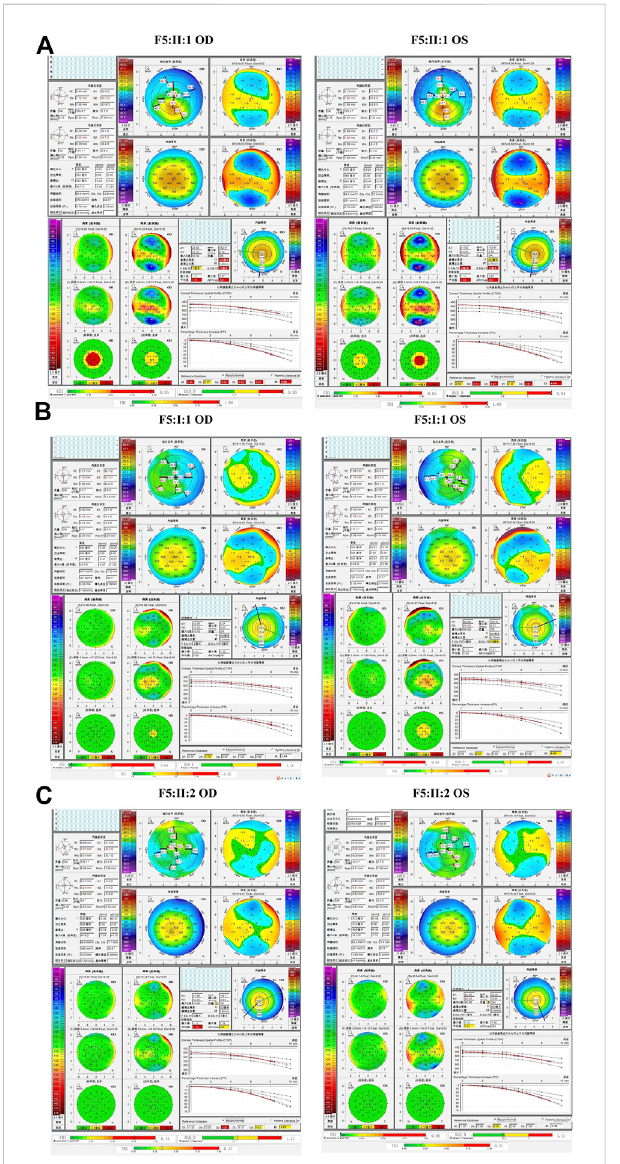
FIGURE 9 Pentacam and Corvis ST images of the proband and asymptomatic fi rst-degree relatives carrying the c.425-73C > T variant in F6. (A) Abnormal corneal topography and biomechanics of the proband. (B) Pentacam and Corvis ST examinations of the mother with the variant revealed eight suspicious parameters (TP, ARTmax, Db, Dt, Da, BAD-D, CBI, and TBI) and one abnormal parameter(Dp)intherighteye,whilesevensuspiciousparameters(TP, ARTmax, Dt, Da, BAD-D, CBI, and TBI) and one abnormal parameter (Dp) were detected in the left eye. (C) Pentacam and Corvis ST examinations of the sister with the variant revealed have four suspicious parameters (ARTmax, Da, BAD-D, and CBI) and one abnormal parameter (Dp) in both